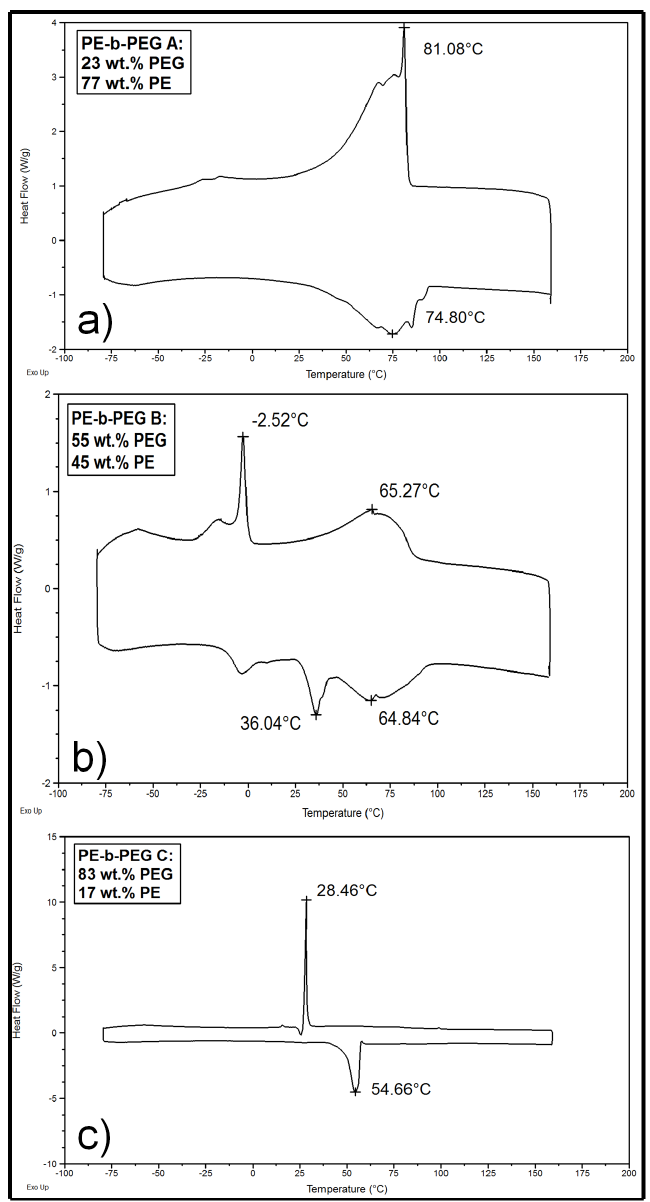
Figure 11. DSC curves of ( a ) PE-b-PEG A, ( b ) PE-b-PEG B and ( c ) PE-b-PEG C during the heating (down) and the cooling (up) ramps.